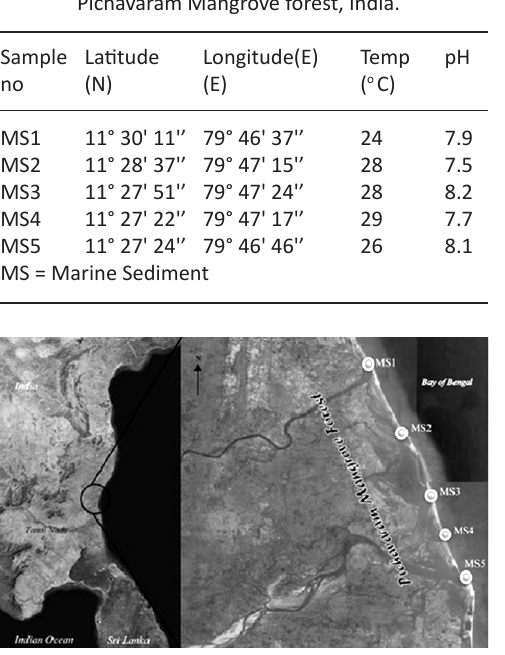
Table 1. Characteristics of samples collected